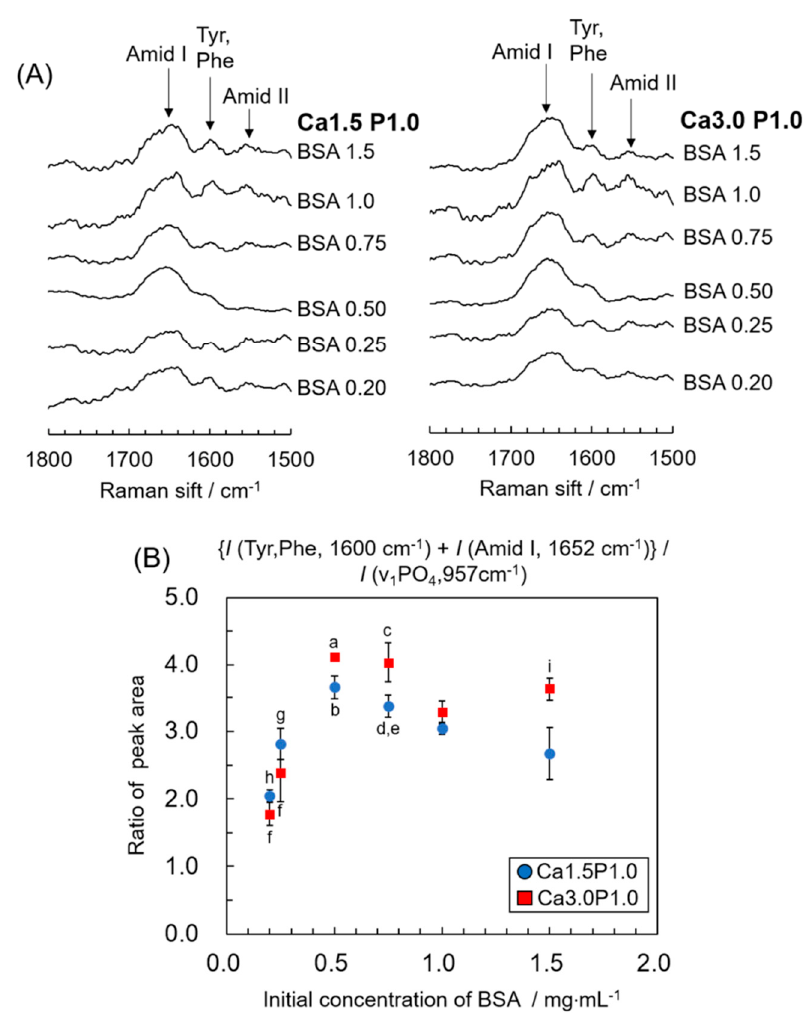
Figure 5. Magnified Raman spectra between 1500 to 1800 cm − 1 ( A ) and change in integrated intensity ratio of the total of two BSA peaks at 1600 and 1653 cm − 1 to the OCP peak at 957 cm − 1 ( B ) after incubation with BSA solutions. a p < 0.01 significant difference for 0.20, 0.25 and 1.0 mg·mL − 1 BSA in Ca3.0P1.0; b p < 0.01 significant difference for 0.20, 0.25 and 1.5 mg·mL − 1 in Ca1.5P1.0 solution; c p < 0.01 significant difference for 0.20, 0.25 and 1.0 mg·mL − 1 BSA in Ca3.0P1.0. d p < 0.01 significant difference between 0.20 and 0.75 mg·mL − 1 BSA, and e p < 0.05 significant difference from 1.5 mg·mL − 1 BSA in Ca1.5P1.0; f p < 0.01 significantly different for 1.0 and 1.5 mg·mL − 1 BSA in Ca3.0P1.0; g p < 0.05 significant difference for 0.20 mg·mL − 1 BSA and h p < 0.01 significant difference from 1.0 mg·mL − 1 BSA in Ca1.5P1.0. i p < 0.05 significant difference from 1.5 mg·mL − 1 BSA in Ca1.5P1.0. Mean values were obtained from three independent experiments (n = 3).